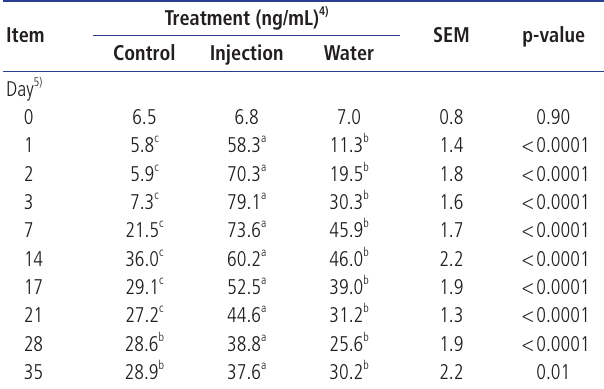
Table 4. Time-dependent serum 25-OHD with vitamin